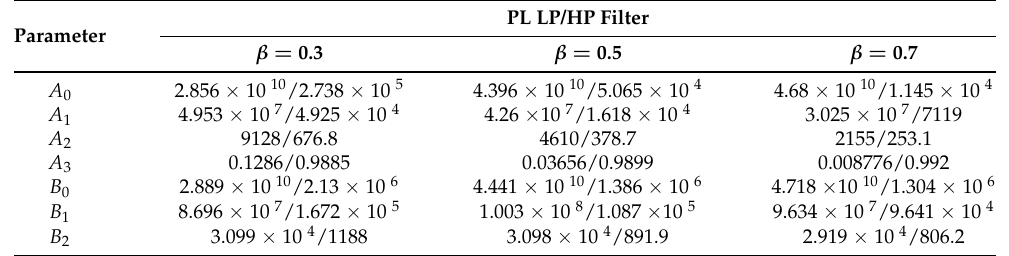
Figure 2. MATLAB gain and phase frequency responses of (8) and (11) for ( a ) third-order approxi- (cid:2) (cid:3) mation in the range 10 0 ,10 + 4 Hz and ( b ) fifth-order approximation in the range Table 1. Coefficients of the transfer function in (14) for approximating LP and HP power-law filters